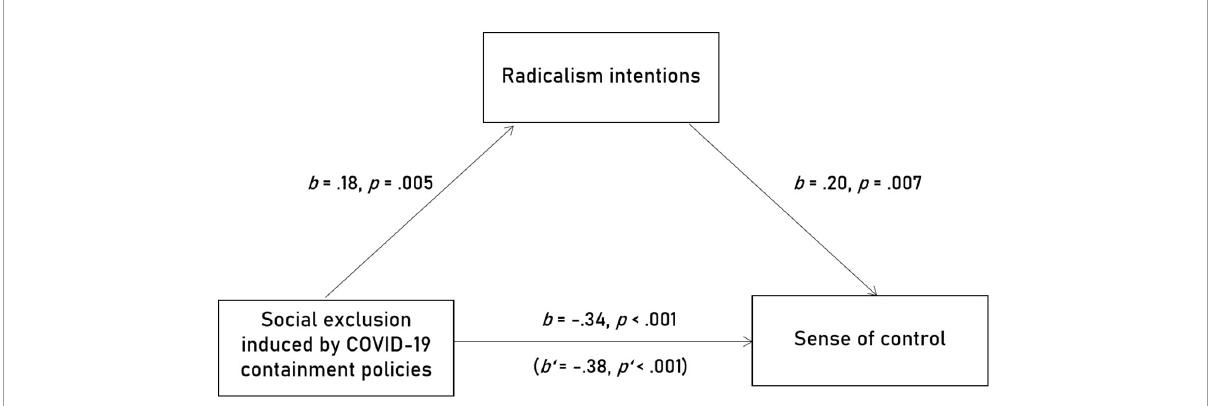
FIGURE2 Results of the mediation analyses: Feelings of exclusion that were per se associated with lower control increased radicalism. In turn, radicalism translated to a perceived increase of control.